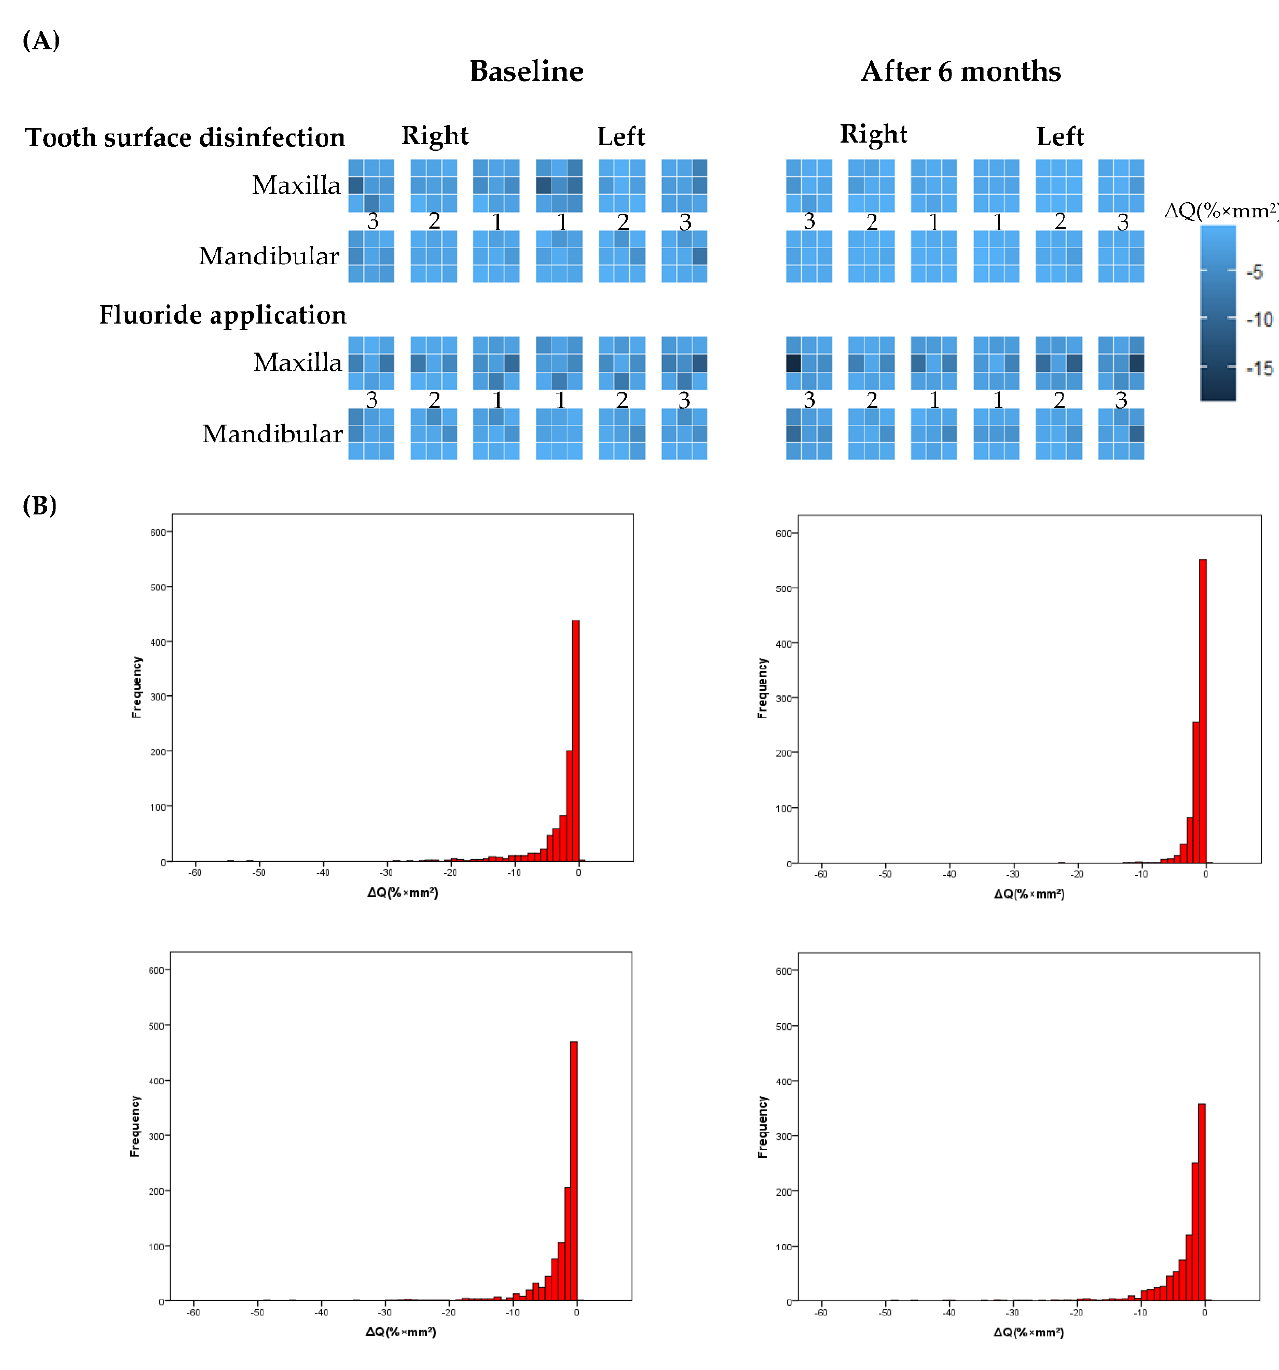
Figure 2. Changes of Δ Q value evaluated by QLF. ( A ) Heatmap by segmentation of nine areas in each tooth. ( B ) Histogram of white spot parameters.